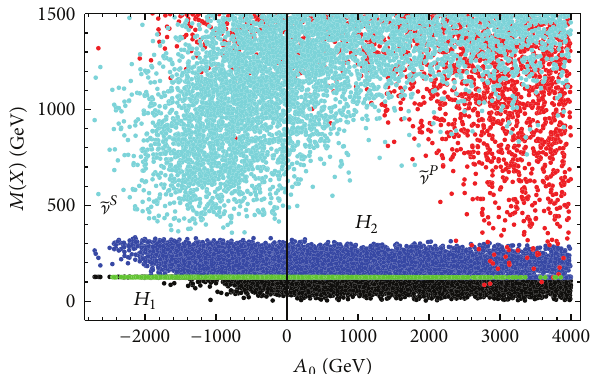
Figure 1: Masses of 𝐶𝑃 -even ( ̃ ] 𝑆 , cyan) and 𝐶𝑃 -odd ( ̃ ] 𝑃 , red) R- sneutrinos as a function of 𝐴 0 . For comparison, also the masses of the lightest ( 𝐻 1 , black) and next-to-lightest ( 𝐻 2 , blue) Higgs bosons are shown. Configurations when 𝑀 𝐻